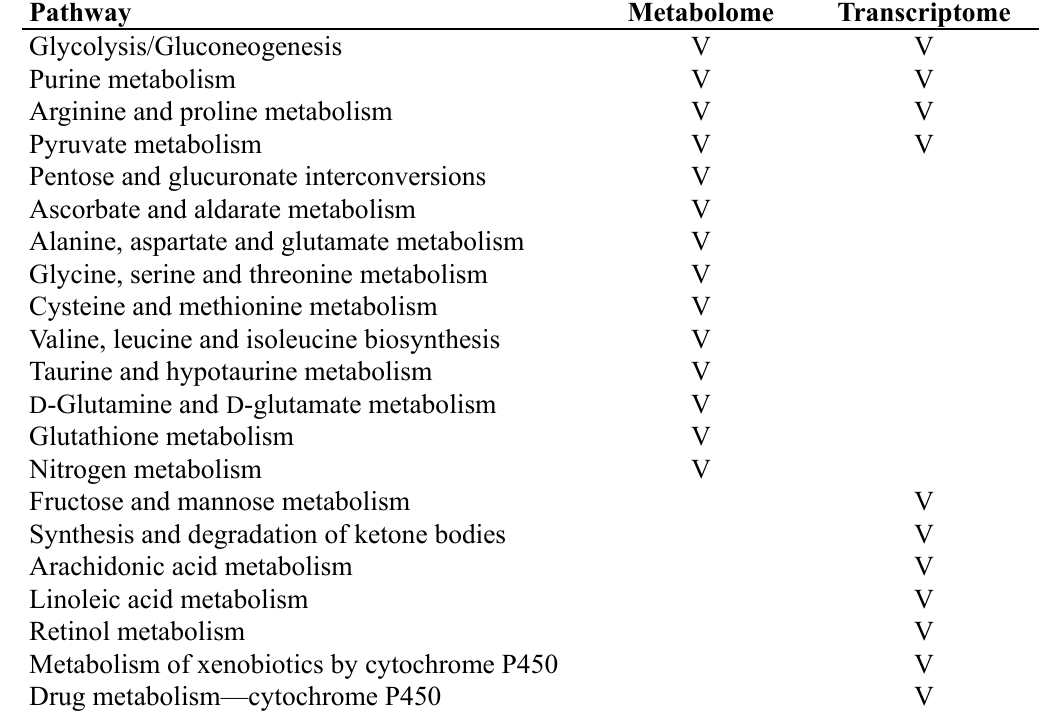
Table 2. Pathways involved with metabolites from metabolome and transcriptome study. Metabolomics pathways inferred under hypoxia treatment were identified from our study. Transcriptomics pathways inferred under hypoxia treatment were obtained from the published